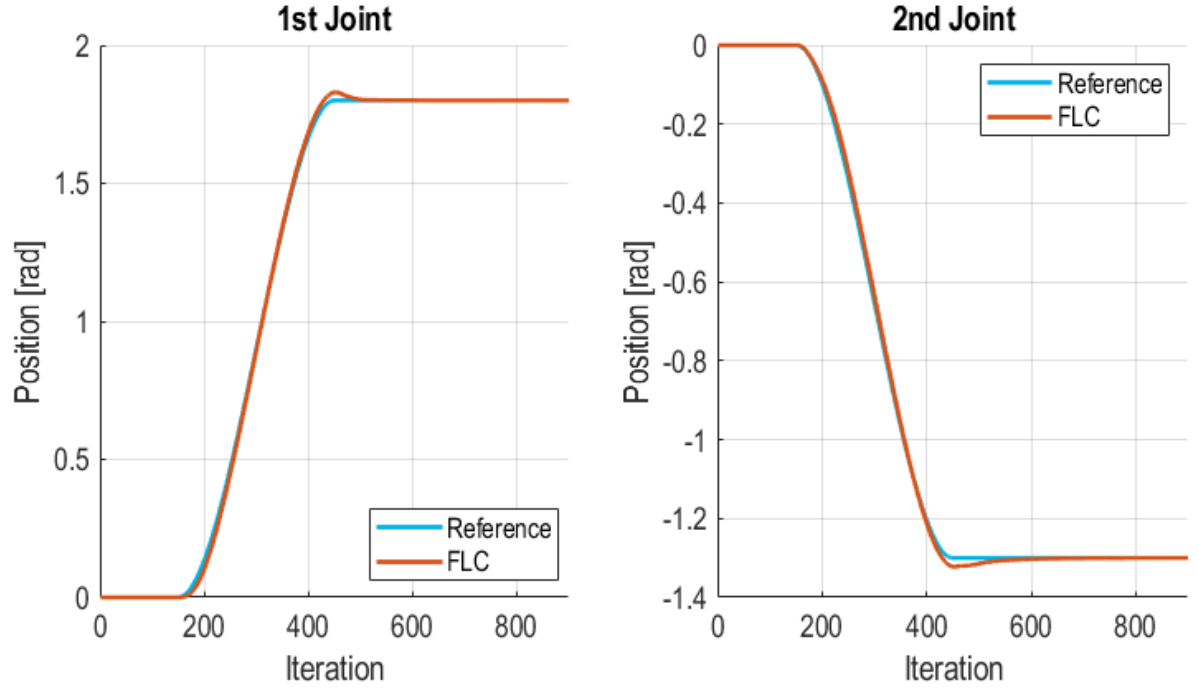
Figure 11. FLC for a cubic trajectory without communication errors.